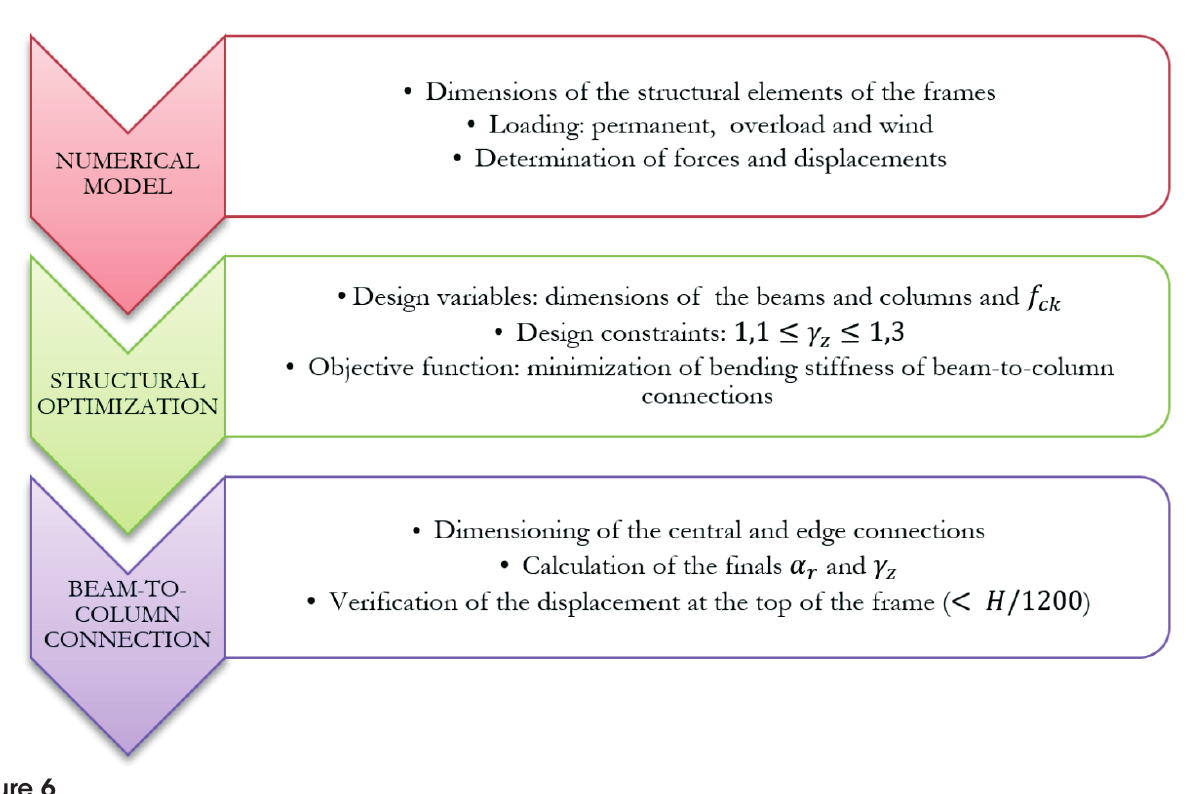
Frame analysis flow chart